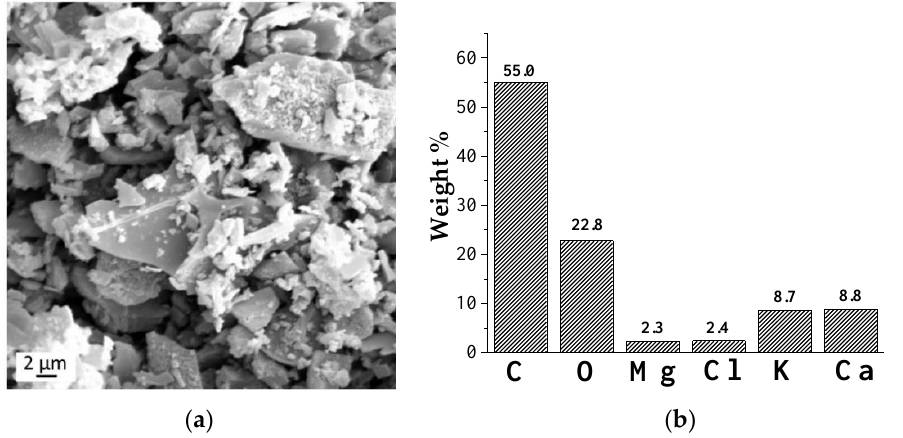
Figure 1. SEM micrograph ( a ) and EDX analysis ( b ) of the hemp hurd-derived biochar (HHB) at 1000 °C. 1000 ◦